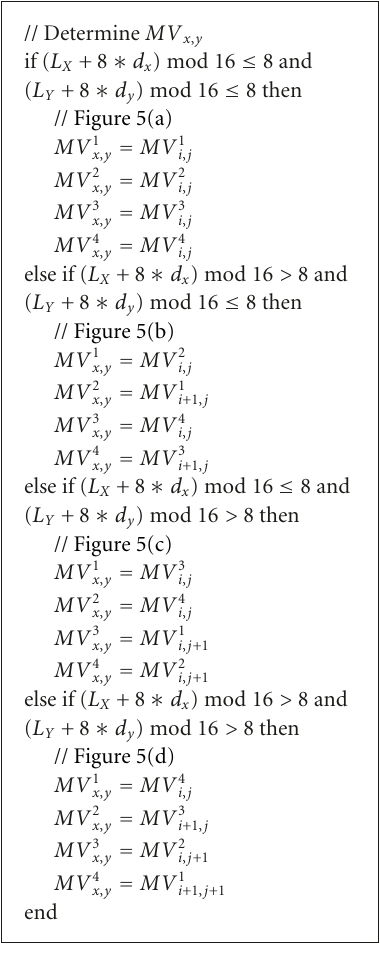
Algorithm 4: Determine MV x , y